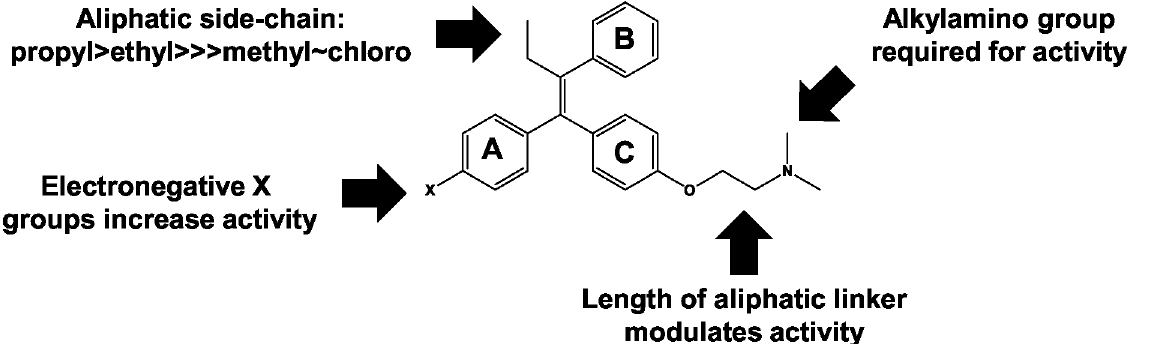
Fig 7. Summary of structure-activity